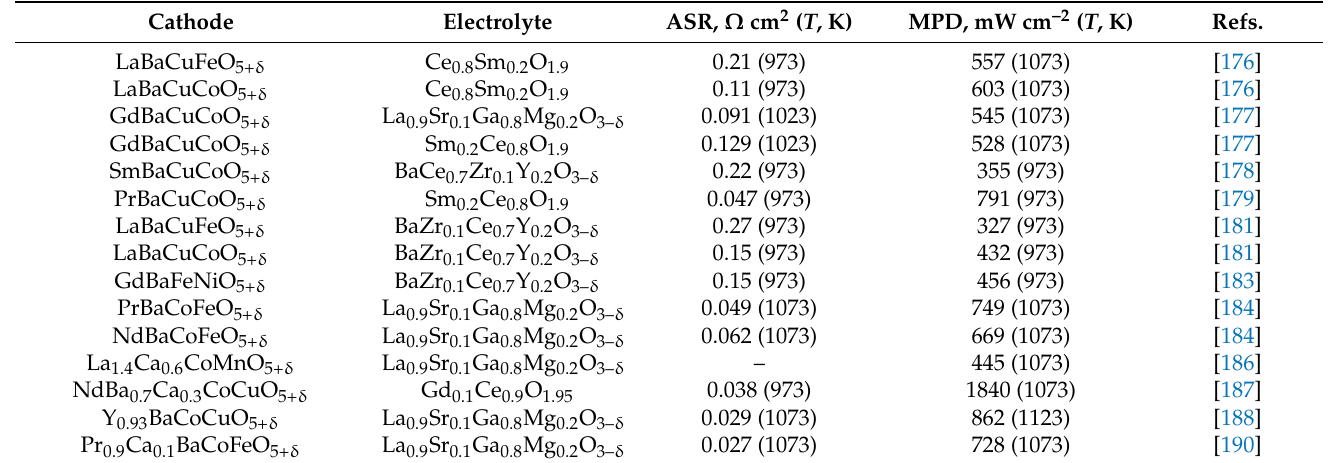
Table 7. Performance (ASR: area specific resistance, MPD: maximal power density) of SOFCs based on Ln BaMe’Me”O 5+ δ compounds.